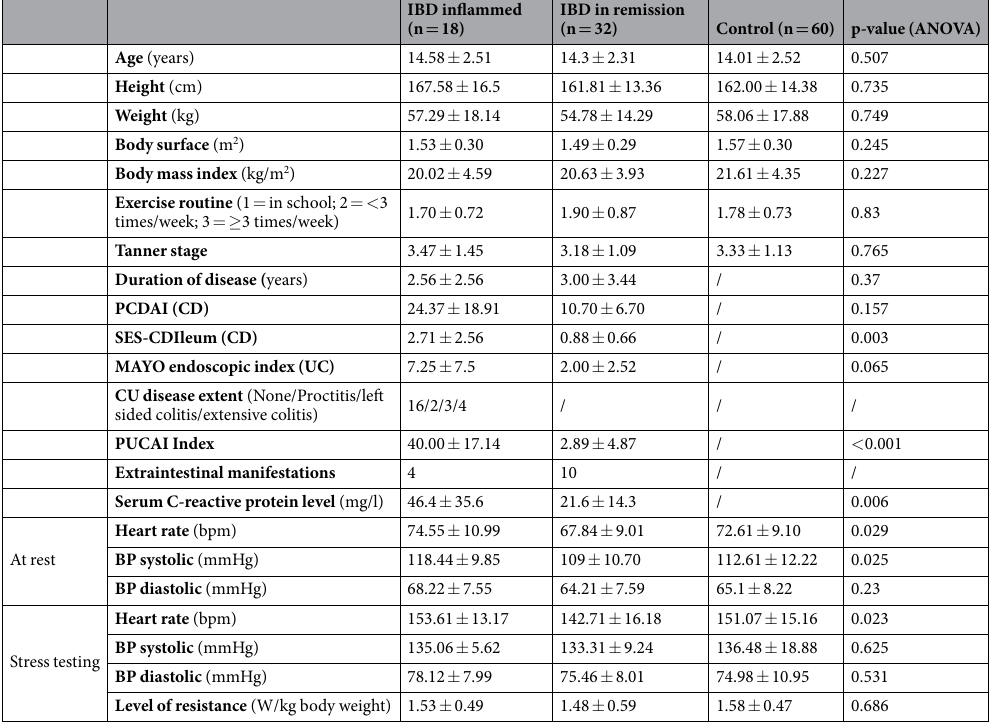
Table 1. Baseline clinical characteristics and hemodynamics of the study population. #SES-CD = Simple